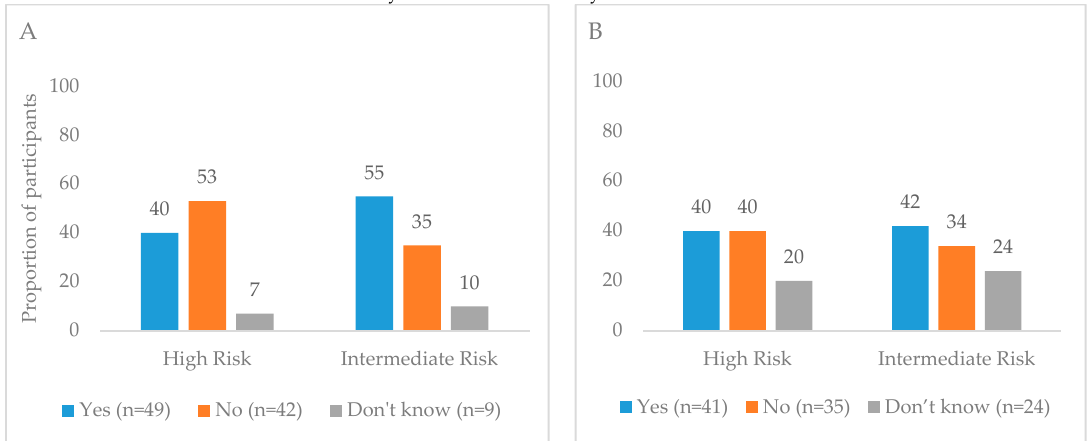
Figure 1. Comparison of perceptions of omega-3 fatty acids in the diet and their importance to health and omega-3 index in the United States (Panel A ) and Germany (Panel B ). High Risk—Omega-3 index ≤ 4% ( n = U.S., n = 40; Germany, n = 10); Intermediate Risk—Omega-3 index 4–8% ( n = U.S., n = 60; Germany = 90); * Statistically significant, p -value < 0.05. Table 2. Mean (95%CL) Omega-3 Index by sex and perception of dietary adequacy among adults in the United States and Germany ( n = 200; ages 18–80 years) 1 .